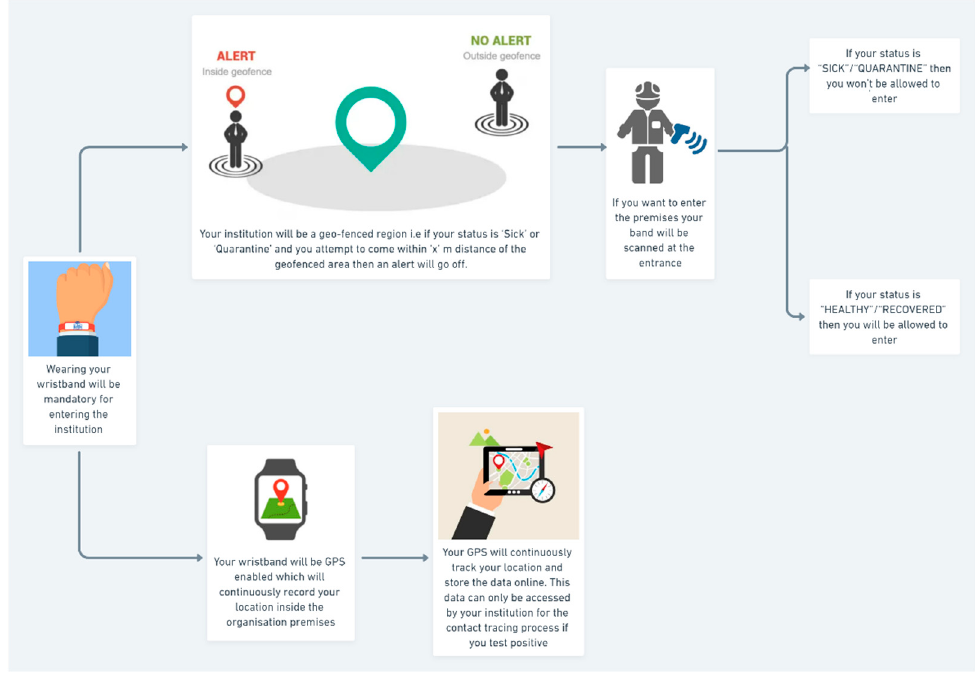
Figure 3. Flow diagram of COVID ‐ 19 contact tracing process .